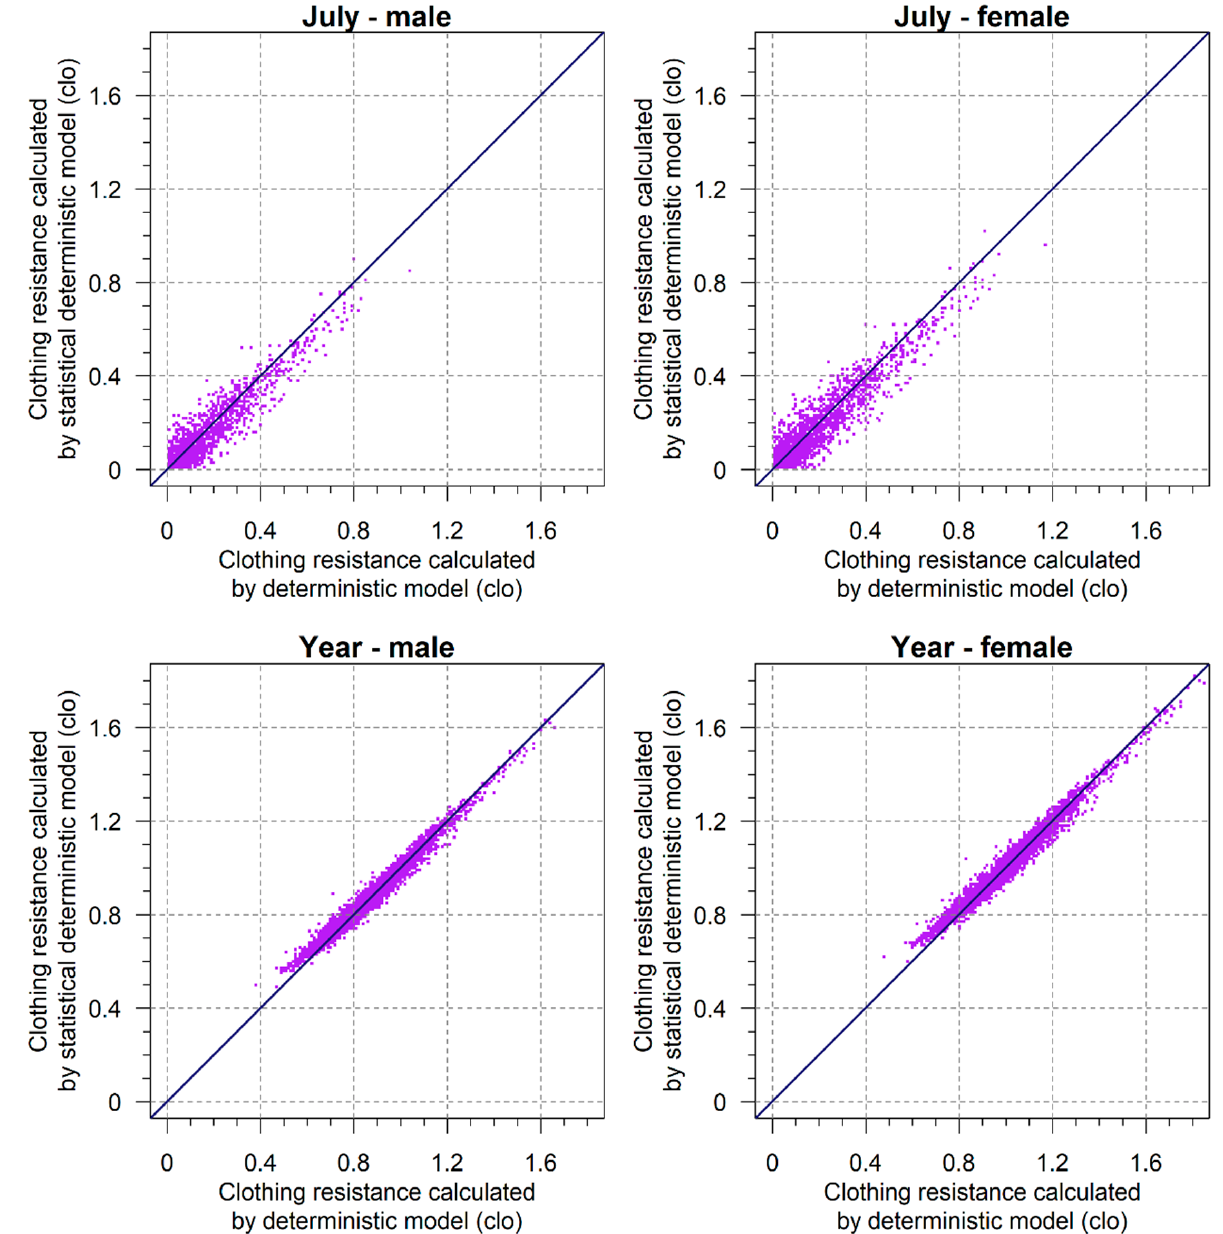
Figure 5. Comparison of clothing thermal resistances obtained by calculating operative temperature by using statistical deterministic and deterministic procedures for persons 1 and 2 representing an average adult Hungarian male and female, respectively, in the month of July ( top ) and in the year ( bottom ) in the CarpatClim dataset region for the period 1971–2000. Each point-cloud contains about 6000 points. All figures, except Figure 3, are constructed by the R programming language [42].